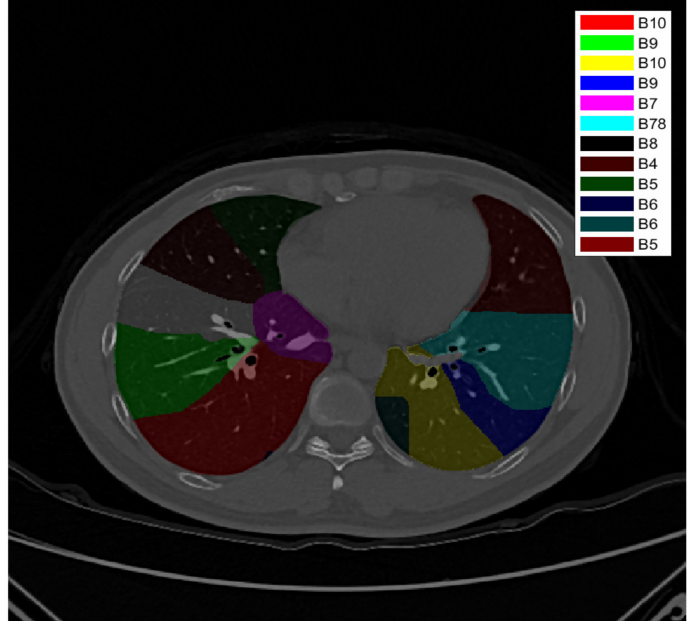
Figure 15. Navigation